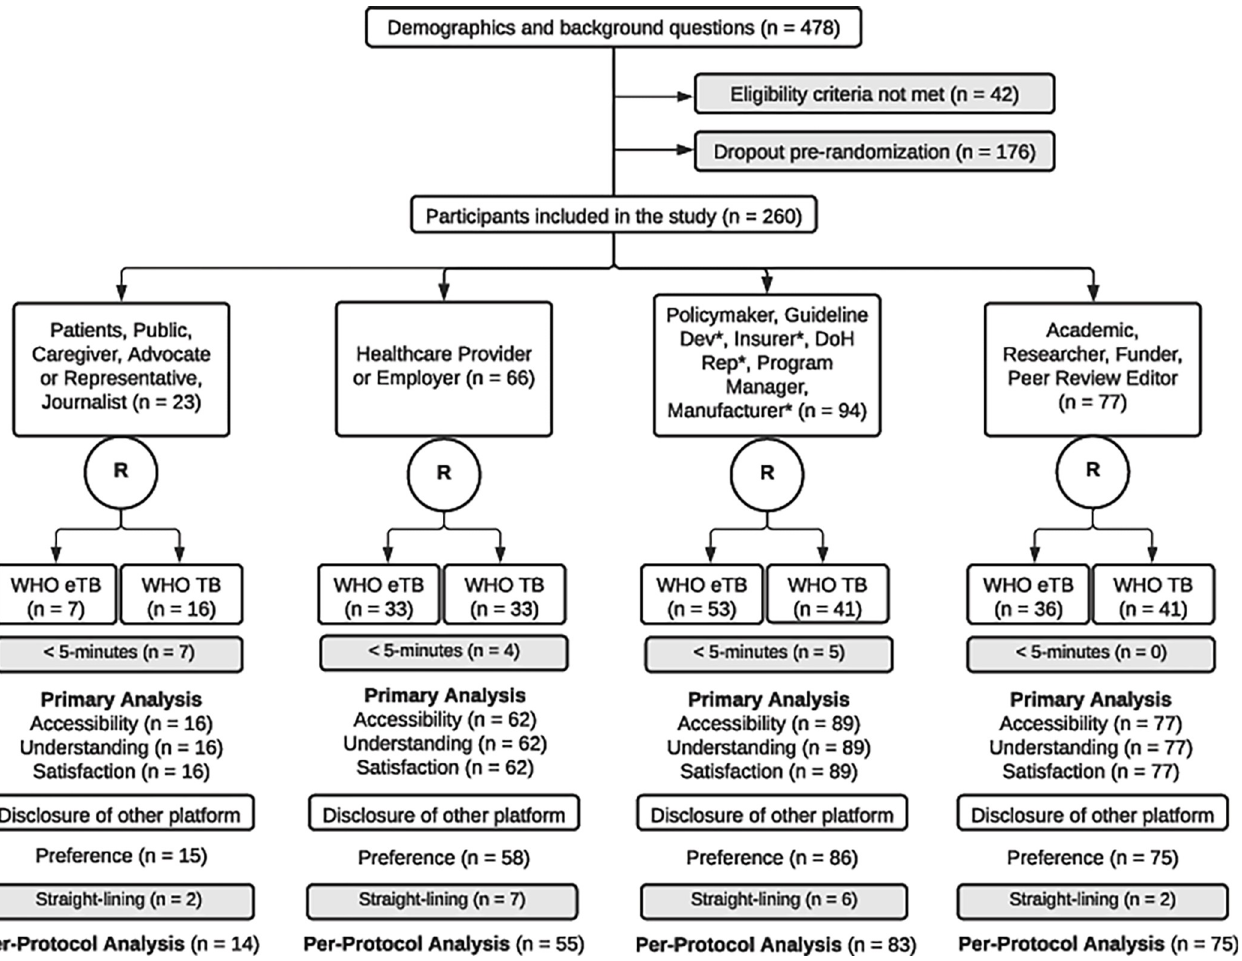
Fig 1. This figure shows the flow of participants through the study. The following abbreviations are included: Guide Dev: Guideline developer; Insurer: Insurer of health services; DoH Rep: Department of health representative; Manufacturer: Drug or device manufacturer.